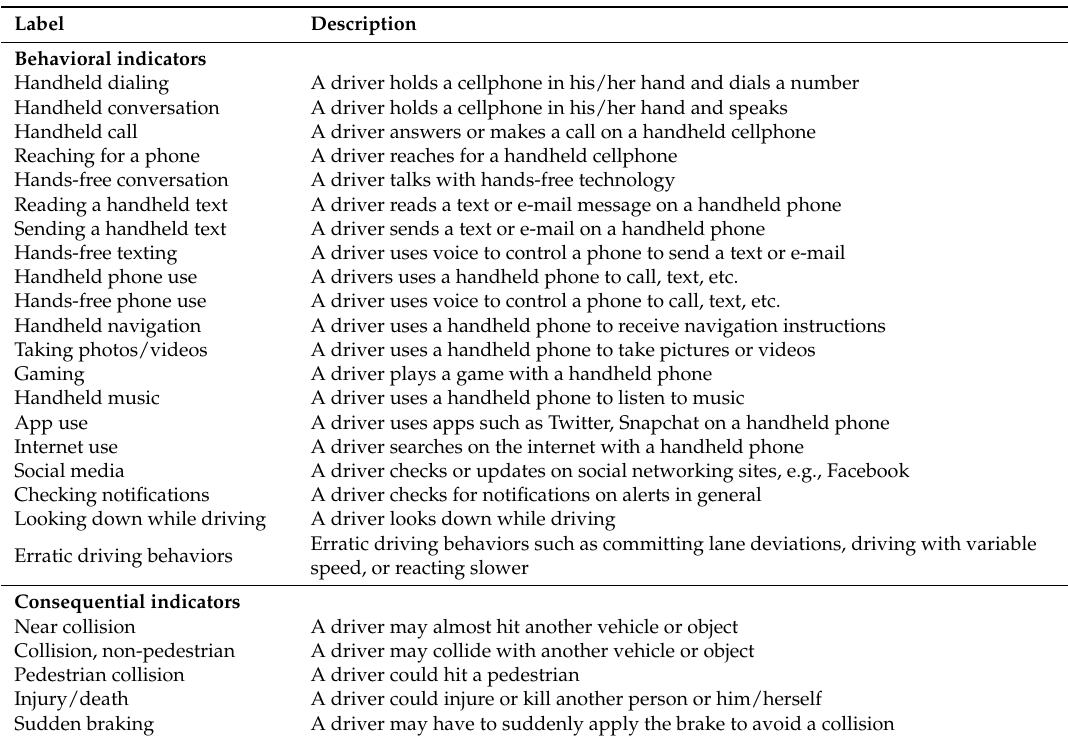
Table 1. Behavioralandconsequentialindicatorsproposedbyexpertsandyoungdrivers,